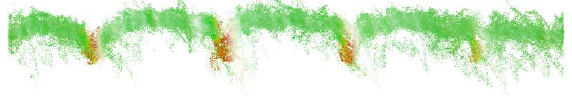
Figure 4. Cross section of a point cloud of a winter wheat experimental plot. Classified ground points are brown and vegetation point are shown in